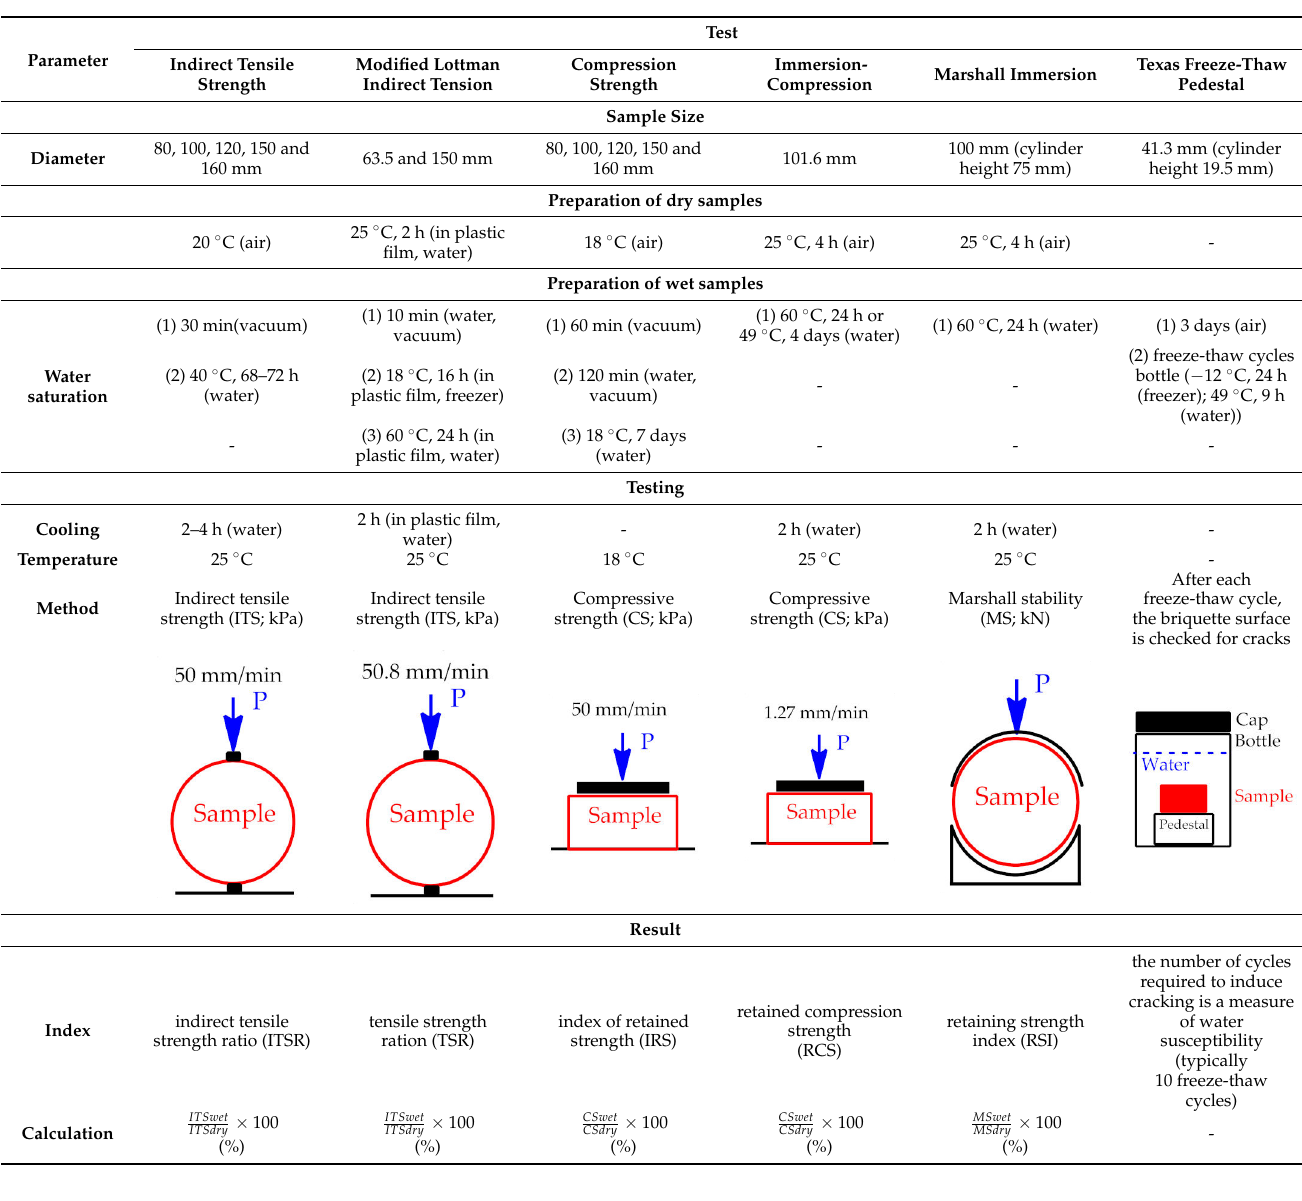
Table 3. Conditions the main most common methods on Compacted Cylindrical